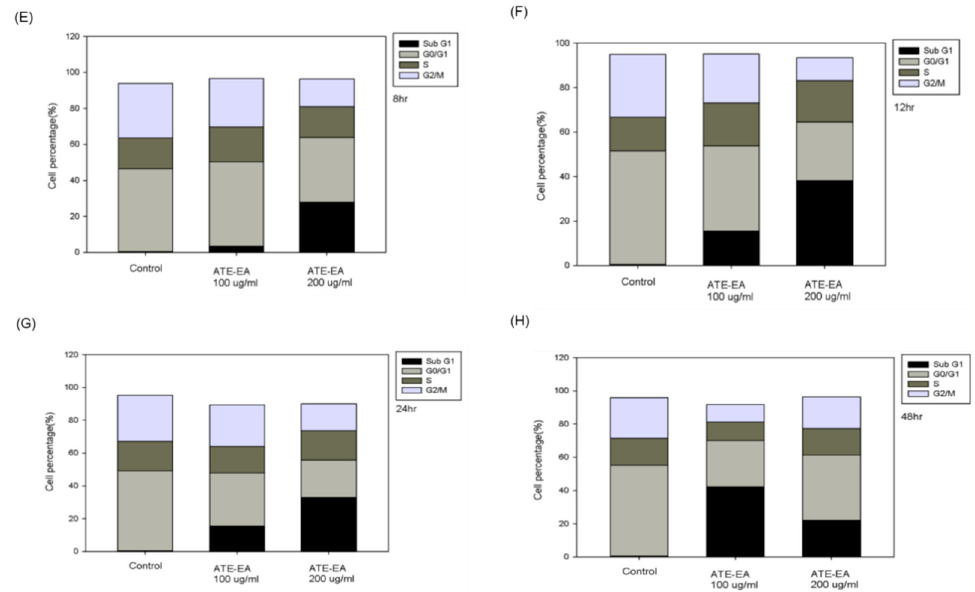
Figure 7. The effects of ATE-EA on the cell cycle distribution. HEC-1A cells were treated ATE-EA at 100 and 200 μ g/mL for: ( A ) 8 h; ( B ) 12 h; ( C ) 24 h; and ( D ) 48 h. RL95-2 cells were treated ATE-EA at 100 and 200 μ g/mL for: ( E ) 8 h; ( F ) 12 h; ( G ) 24 h; and ( H ) 48 h. Analysis of the cell cycle was done by flow cytometry. Representative histograms of cell cycle progression. Sub-G1; G0/G1; S; G2/M. ATE-EA, ethyl acetate fraction of the adlay testa ethanolic extract.